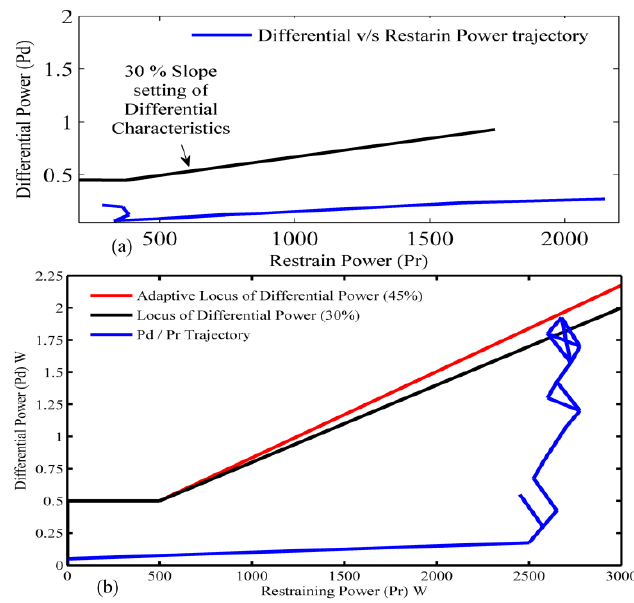
Fig. 10. Differential vs restraining power characteristic during external faultcondition: (a) without CT saturation, (b) with CT